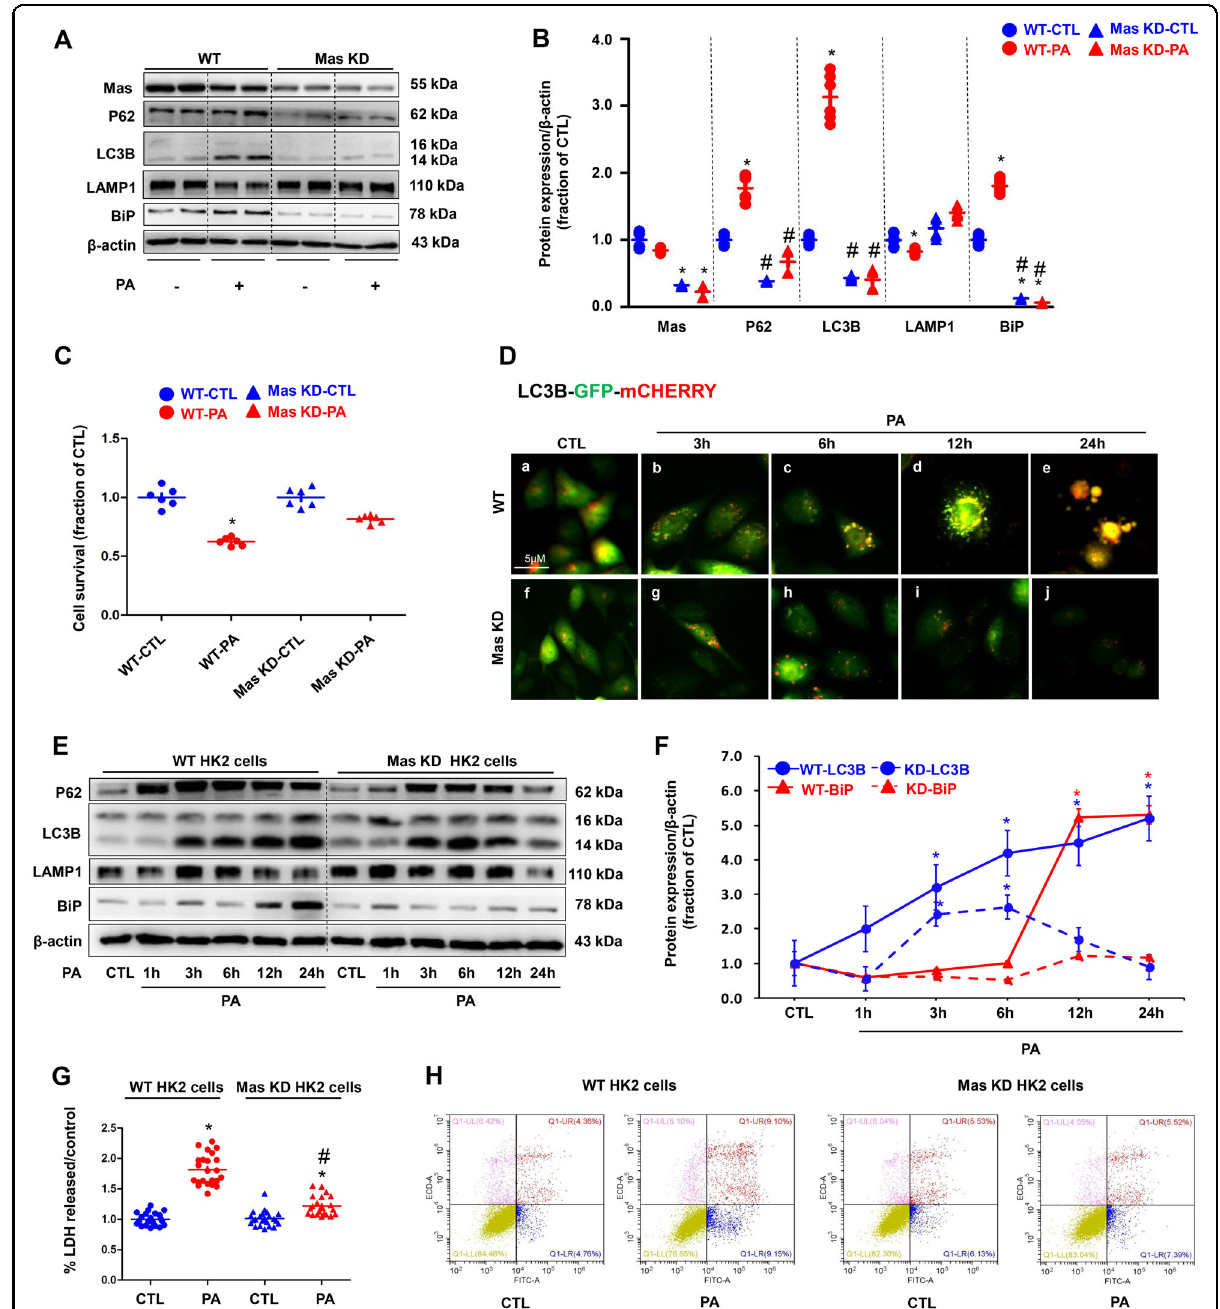
Fig. 5 Mas knockdown (KD) prevented PA-induced impaired autophagy and ER stress in HK2 cells. A and B Representative immunoblots and corresponding densitometry analysis of protein markers of autophagy (assessed by P62, LC3B and LAMP1) and ER stress (assessed by BiP) in WT and Mas knockdown HK2 cells treated with PA (400 μ M) for 24 h. C Cell survival ratio of WT HK2 cells and Mas knockdown HK2 cells were treated with either BSA or PA 400 μ M for 24 h assessed by CCK. D Confocal microscopy images of WT and Mas knockdown HK2 cells treated with PA followed by transfection with LC3B-GFP-mCherry adenovirus for 3 h, 6 h, 12 h, 24 h. E Representative immunoblots of autophagy protein markers (assessed by P62, LC3B and LAMP1) and activation of the ER stress (assessed by BiP) in WT and Mas knockdown HK2 cells treated with PA (400 μ M) for 1 h, 3 h, 6 h, 12 h, 24 h. β -actin was used as a loading control. F Dynamic changes of LC3B and BiP protein expression in WT and Mas knockdown HK2 cells treated with PA. G LDH release by WT HK2 cells or Mas knockdown HK2 cells that were treated with either BSA or PA 400 μ M for 24 h. H Programmed cell death was detected by fl ow cytometry using Annexin V-FITC/PI apoptosis detection kit in WT HK2 cells and Mas knockdown HK2 cells that were treated with either BSA or PA 400 μ M for 24 h. WT, wild type; Mas KD, Mas knockdown. CCK, cell counting kit 8. Data are shown as mean ± SEM; * P < 0.05 compared with CTL; # P < 0.05 compared with PA. The experiment was repeated three